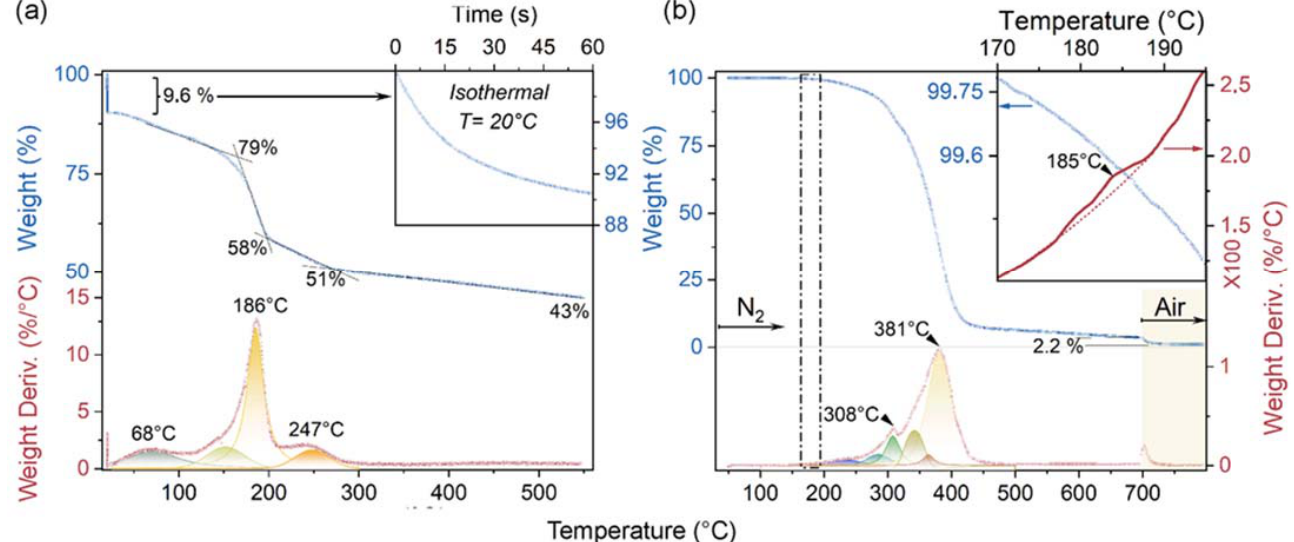
Figure 2. TGA (blue curves) and DTGA (red curves) plots of GO sheets ( a ) and 2 wt.% GO ‐ loaded PU leather layer ( b ), obtained under N 2 (up to 700 °C) or air flow (from 700 °C up to 800 °C). In the insets of ( a , b ), the isothermal treatment of GO at 20 °C under N 2 gas flow and the thermograms zoomed in to the 170–195 °C interval for the GO ‐ loaded PU leather layer are shown, respectively. The TGA plot of GO sheets thermally treated under inert conditions (Figure 2a, blue dotted curve) showed weight loss occurring from room temperature to 550 °C. Upon isothermal treatment at 20.1 ◦ C for 60 min (inset of Figure 2a), weight loss of about 10% was observed. In addition, residual weight for GO was 79, 58, 51 and 43 wt.% at 165, 196, 250, and 550 ◦ C, respectively. From the related DTGA weight loss derivative (Figure 2a, red dotted curve), maxima at 68, 186, and at 247 ◦ C were observed. It is noteworthy that weight loss occurring at lower temperatures (< c.a. 120 ◦ C) mainly refers to physiosorbed water on the GO surface, while the remarkable weight stepdown up to 200 ◦ C, matching a